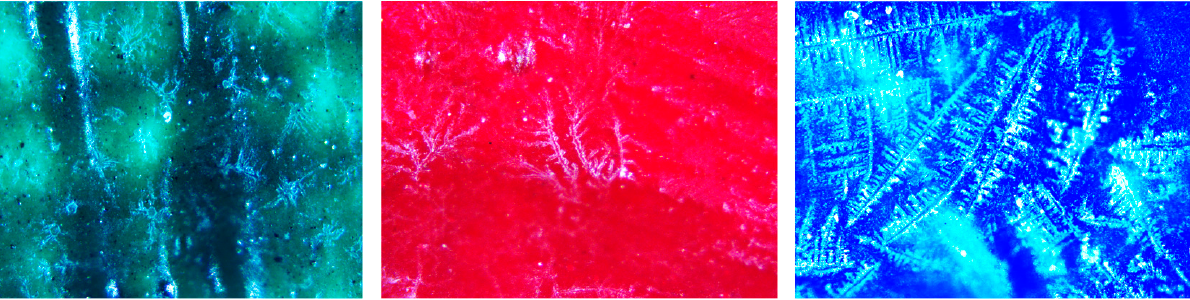
Figure 5. The optical microscopy of the metallic soap generated by the pigments.